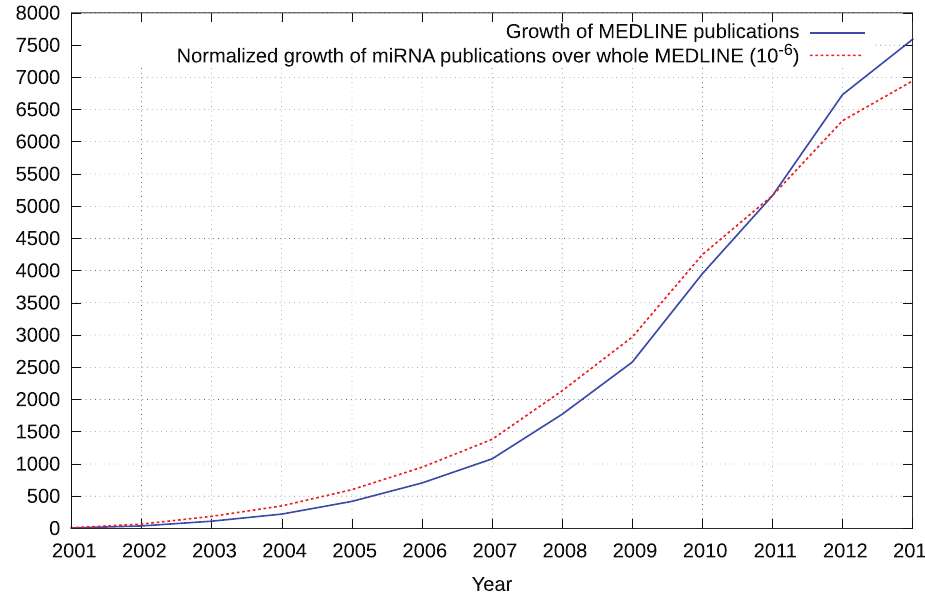
Figure 1. Growth of miRNA-related publications in comparison with the growth of MEDLINE. The dotted line points out the relative increase of miRNA-related publications per year in comparison to the growth of MEDLINE (as of 31 December,